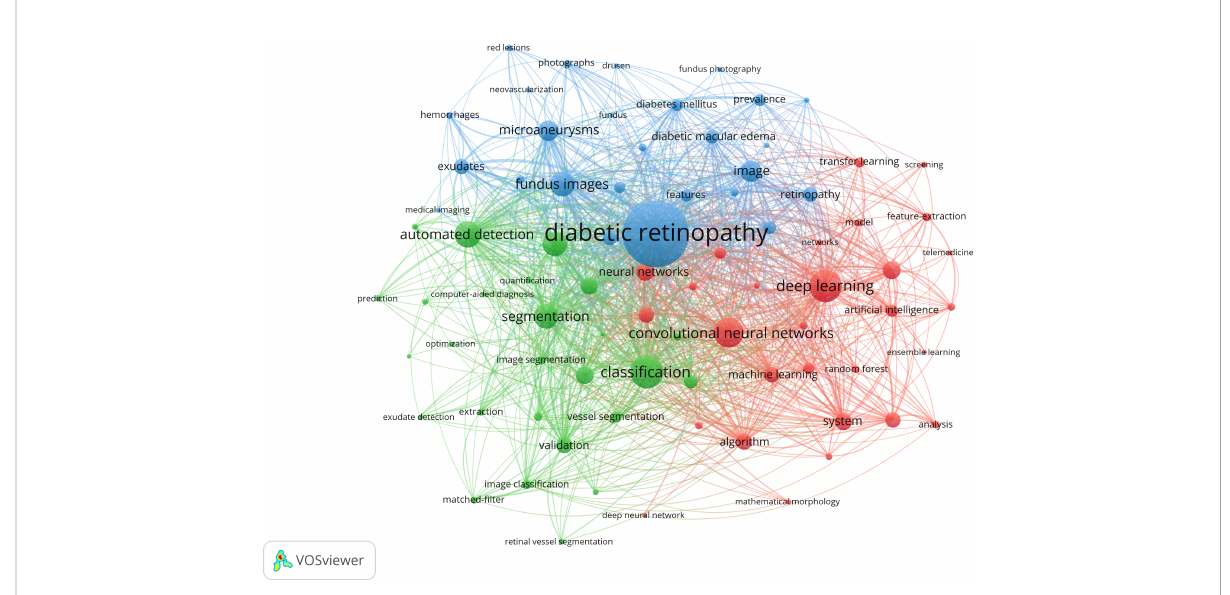
FIGURE 4 The co-occurrence map of keywords; reveals 3 clusters (in 3 colors): ML techniques; applications of ML techniques; relevant diseases, clinical features and medical data. Circle size represents the frequency of occurrence; links represent the co-occurrence.